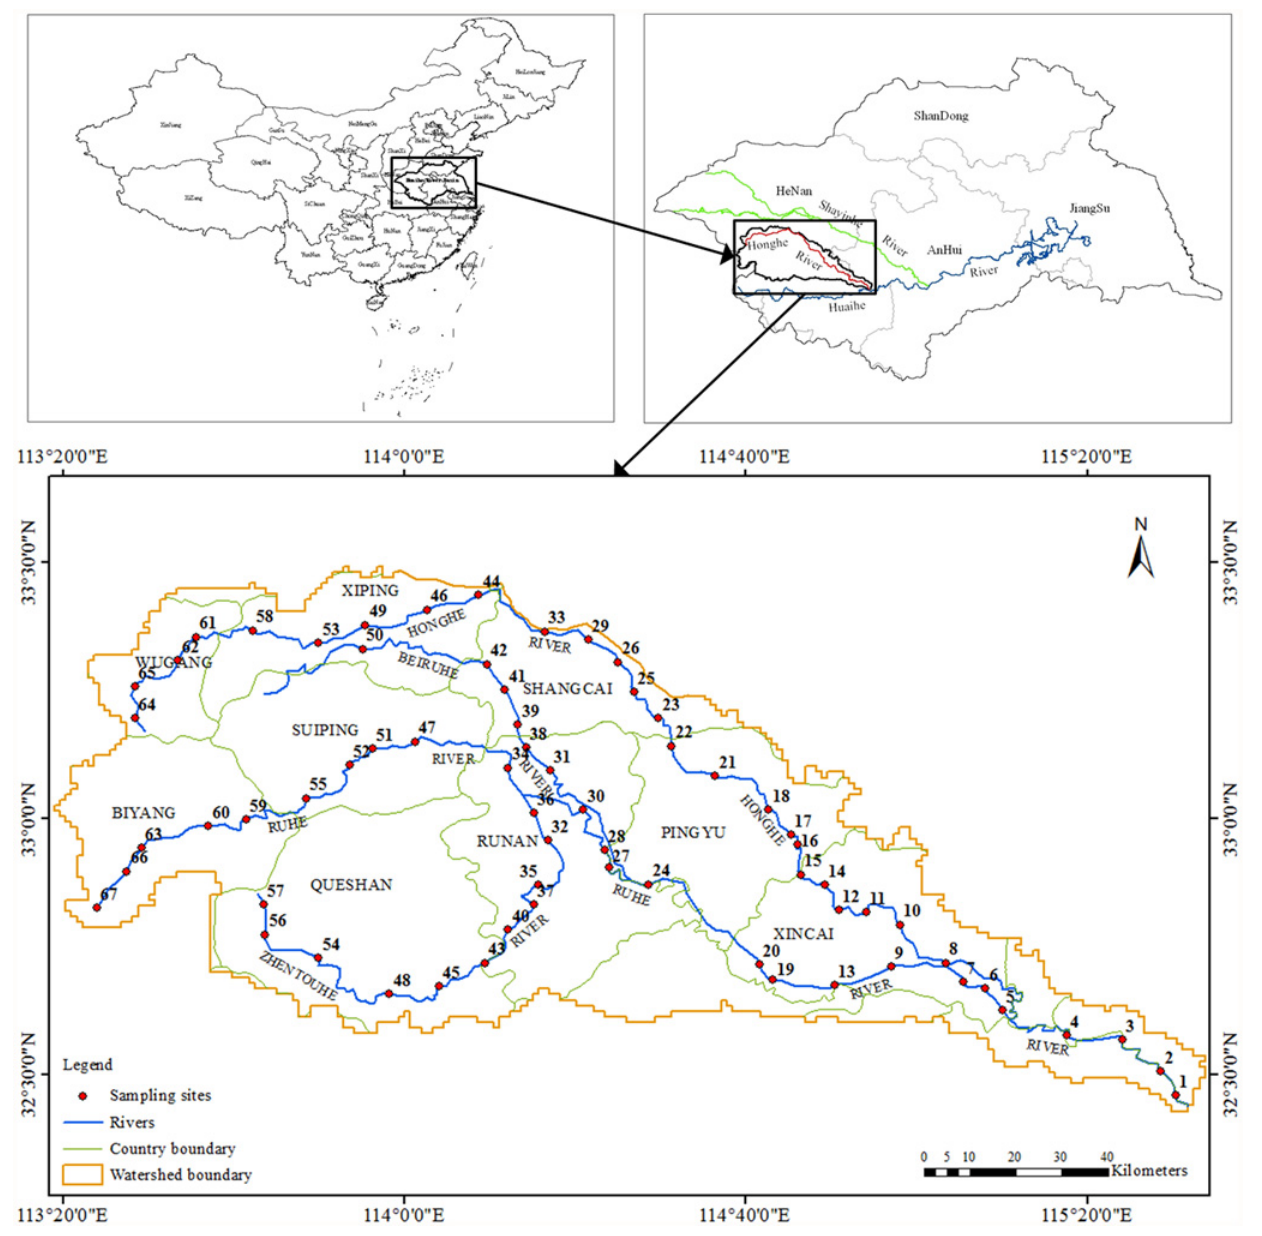
Fig 1. Geographical location and distribution of sampling sites of the Honghe River